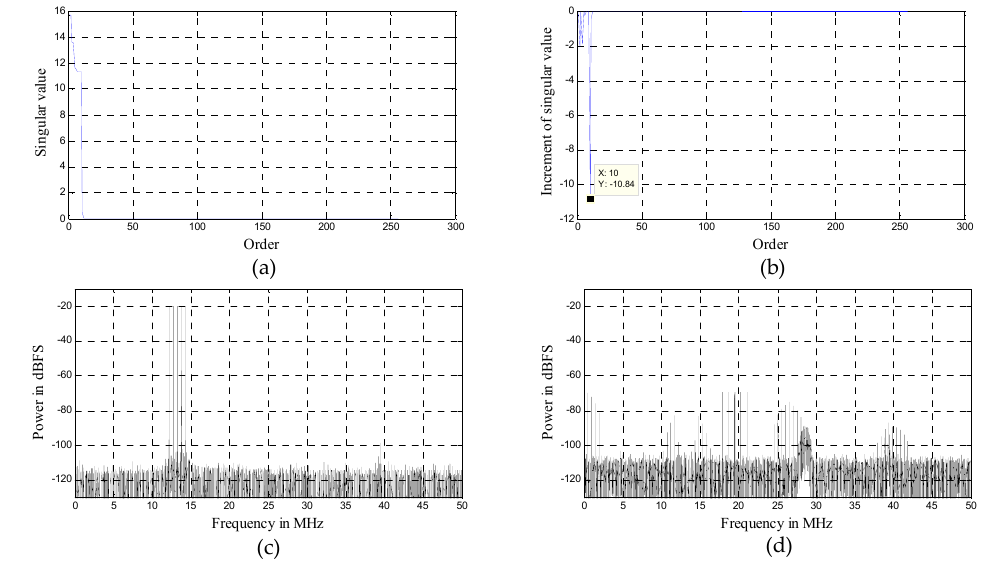
Figure 6. Simulation results of the signal used in Figure 4: ( a ) Curve of singular value; ( b ) Increment curve of singular value; ( c ) Power spectrum of the extracted interferer signal; ( d ) Power spectrum of the distorted signal except the interferer signal.